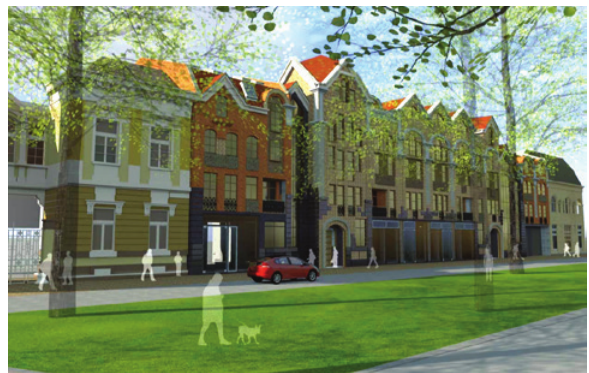
Figure 10. Main façade